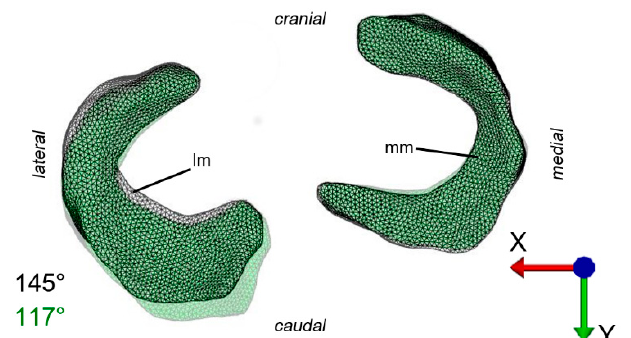
Figure 7. Visualization of maximum translocation/deformation of the medial and lateral meniscus. This semi-transparent overlay of 145°/117° in the X–Y plane shows that both translocation and deformation is higher in the lateral compared to the medial meniscus. Lm = lateral meniscus, mm = medial meniscus.